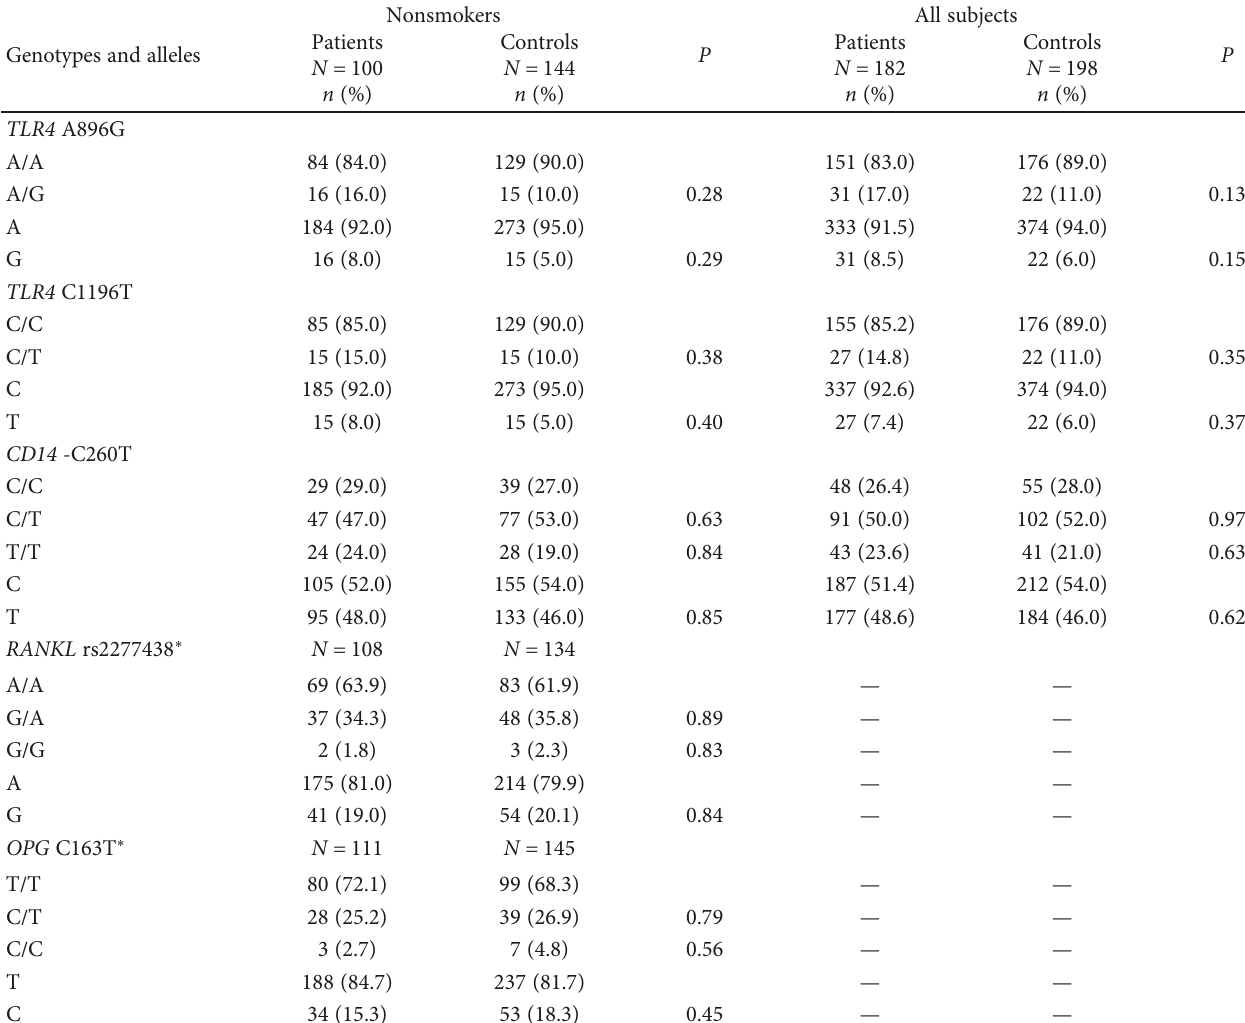
Table 2: Genotype and allele frequency distributions for TLR4 , CD14 , RANKL , and OPG polymorphisms in patients with periodontitis and controls (all subjects and nonsmoking